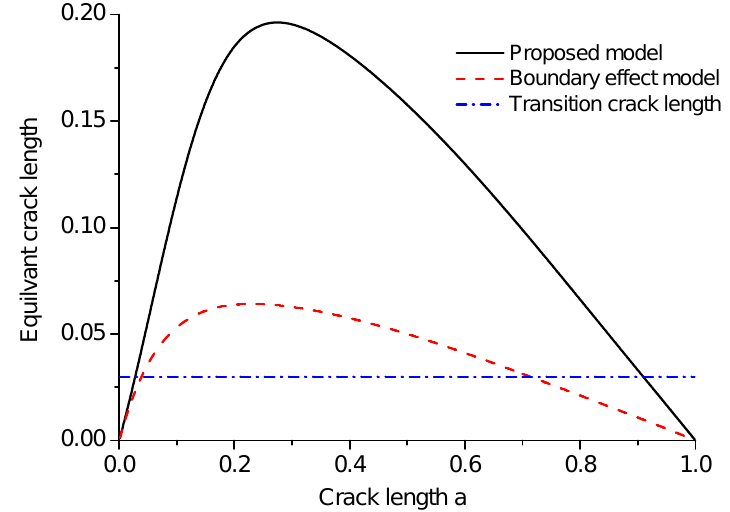
Figure A1. Equivalent crack length in the boundary effect model and the proposed model.